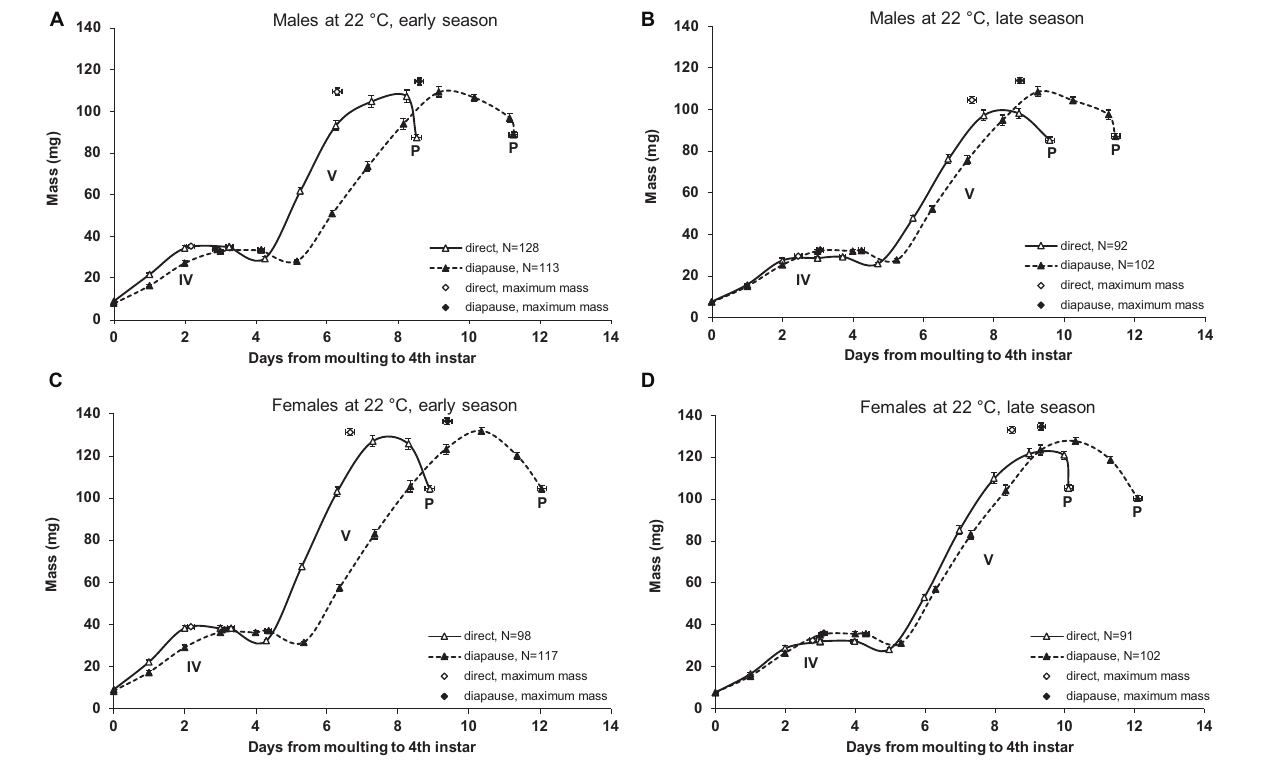
FIGURE 1 | Growth curves of Araschnia levana larvae reared at 22 ◦ C in 2010. (A) Male larvae reared in early season (June). (B) Male larvae reared in late season (August). (C) Female larvae reared in early season. (D) Female larvae reared in late season. Direct development [“long day” (18L:6D) photoperiodic treatment] and diapause [“short day” (12L:12D) photoperiodic treatment] pathways were induced. Values are corrected for the effect of brood (using SAS, PROC MIXED, least square means option, Littell et al., 2006). Roman numerals stand for instars, “P” indicates pupation, and “N” marks sample sizes in the beginning of the instars and in the pupal stage. Error bars indicate standard errors; horizontal error bars stand for standard errors for the duration of the 4th and 5th instar and for the time period from molting until attaining peak body mass in respective